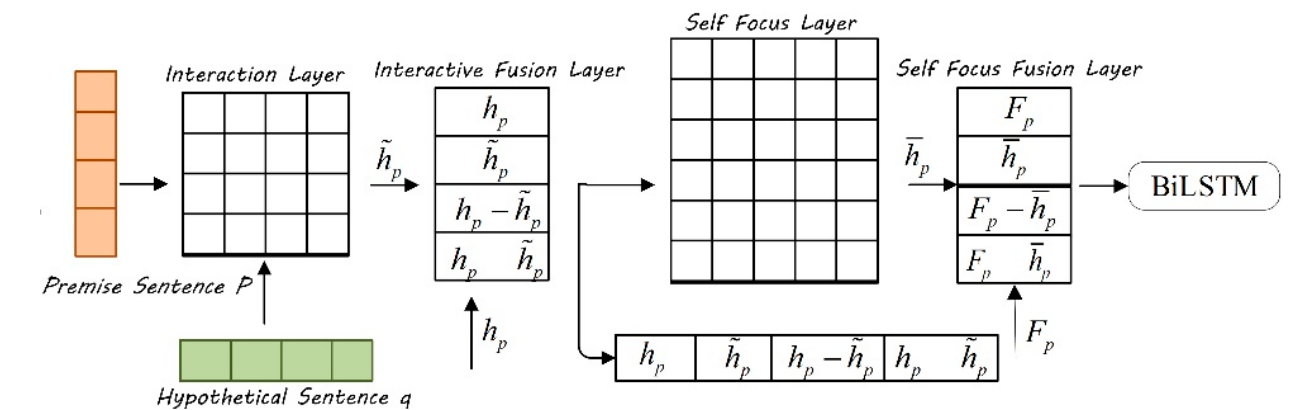
Figure 2. The network structure of the matching layer.